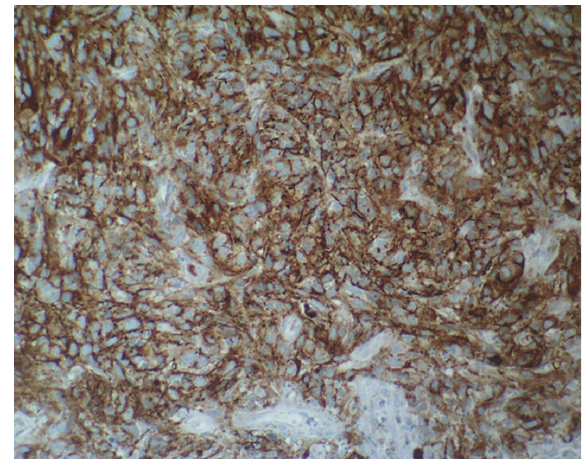
Figure 3: HMB-45 expression in melanoma cells (the immunohis- tochemical stain HMB-45, MSIP ×